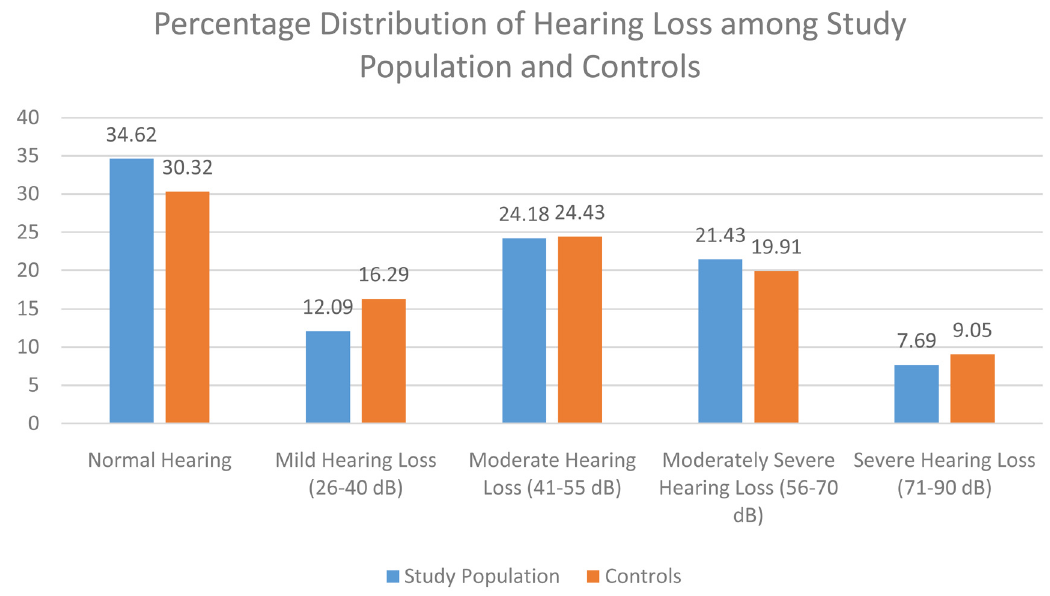
Figure 4. Percentage Distribution of Hearing Lossa Among Study Population and Controls.